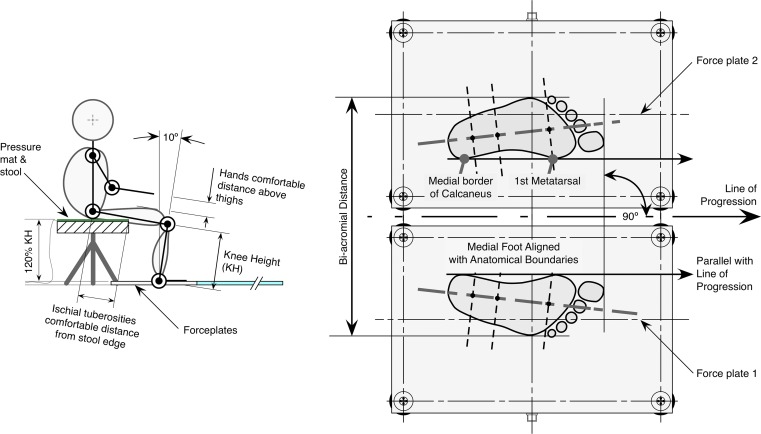
Standardised starting position.Subjects sat on an instrumented stool at 120% knee height (KH) with ischial tuberosities at a comfortable distance from the front edge, ankles 10° degrees in dorsiflexion, hands initially placed at a comfortable distance above thighs to avoid body marker obstruction (left schematic), and feet at shoulder width apart orientated forward (right schematic).